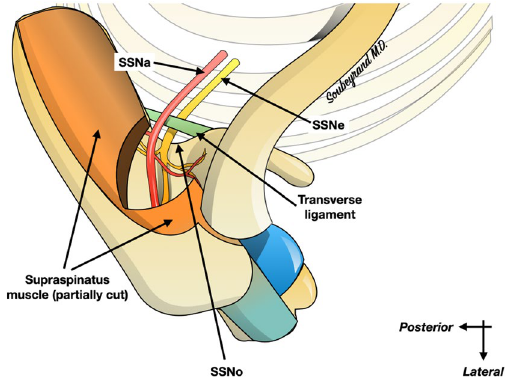
Figure 1. Anatomy of the suprascapular nerve (SSNe) passing through the suprascapular notch (SSNo), under the superior transverse scapular ligament, accompanied by the artery (SSA). The SSNe supplies the supraspinatus muscle as well as the infraspinatus muscle (not shown on the